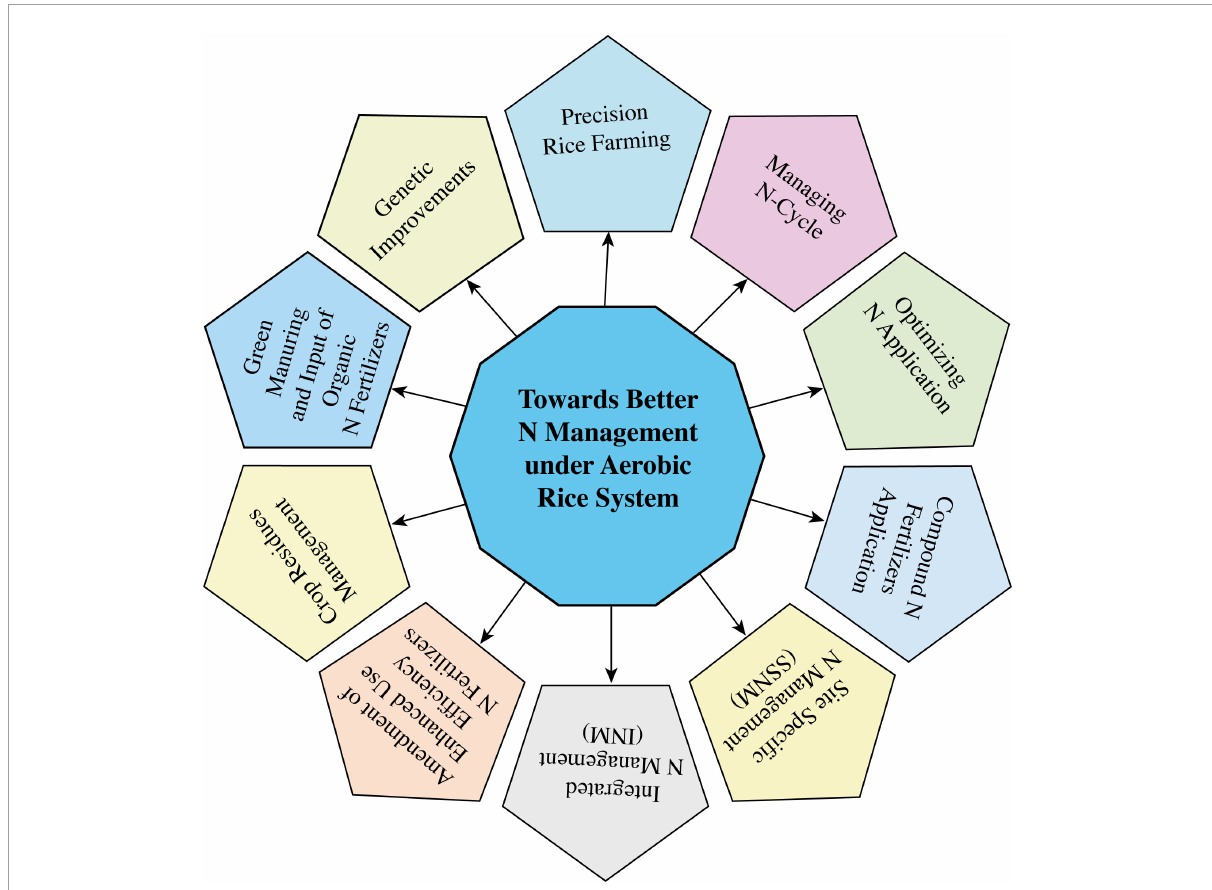
FIGURE6 Eco-efficient management strategies to improve NUE under the aerobic rice system (Farooq et al.,